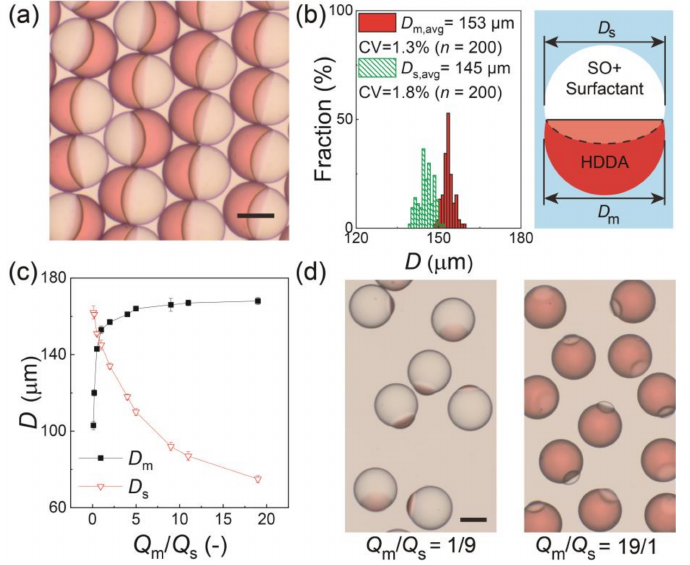
Figure 2. Characterization of Janus droplets with surfactant concentration of 0.1 wt.% at equilibrium. ( a ) Photomicrograph of Janus droplets generated at Q m : Q s = 1:1. ( b ) Size distributions of Janus segments in ( a ). The inset image presents the measured dimensions D m and D s . ( c ) Experimental relationship between Q m / Q s and droplet size. The error bars indicate standard deviation of the measured droplet sizes ( n = 200) ( d ) Photomicrographs of Janus droplets generated at Q m : Q s = 1:9 (left) and 19:1 (right) when Q d, total = 0.6 mL h − 1 and Q c = 8.0 mL h − 1 . Scale bars: 100 µ